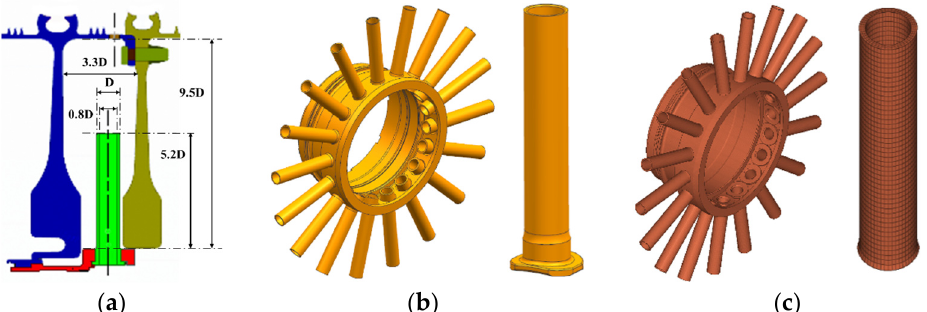
Figure 1. Structural model of the vortex reducer: ( a ) Meridional plane diagram; ( b ) Geometric model; ( c ) Grid model.